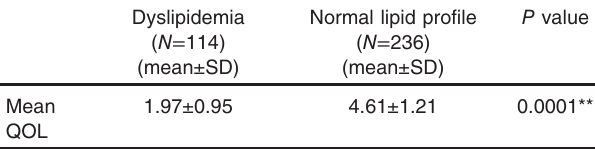
Table 3 Mean scores of quality of life scale in both